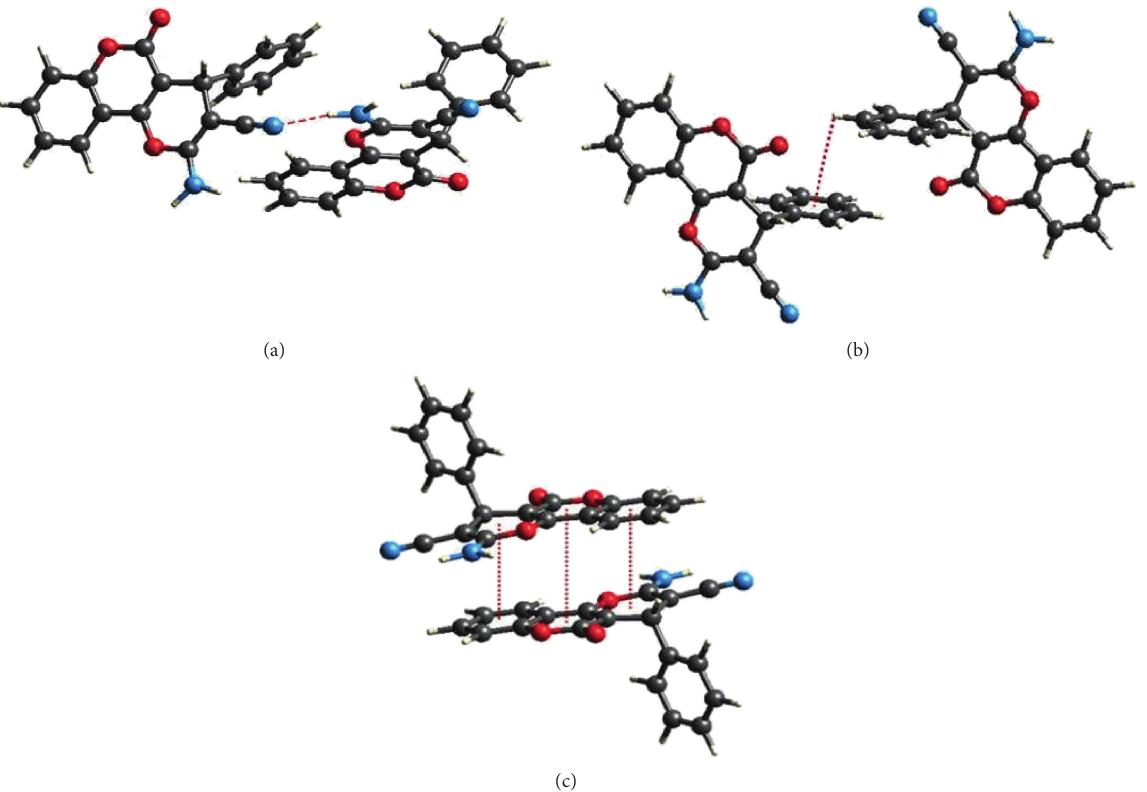
Figure 4: Selected views highlighting individual (a) N-H ... N, (b) C-H . .. π , and (c) π ... π intermolecular interactions indicated in dashed